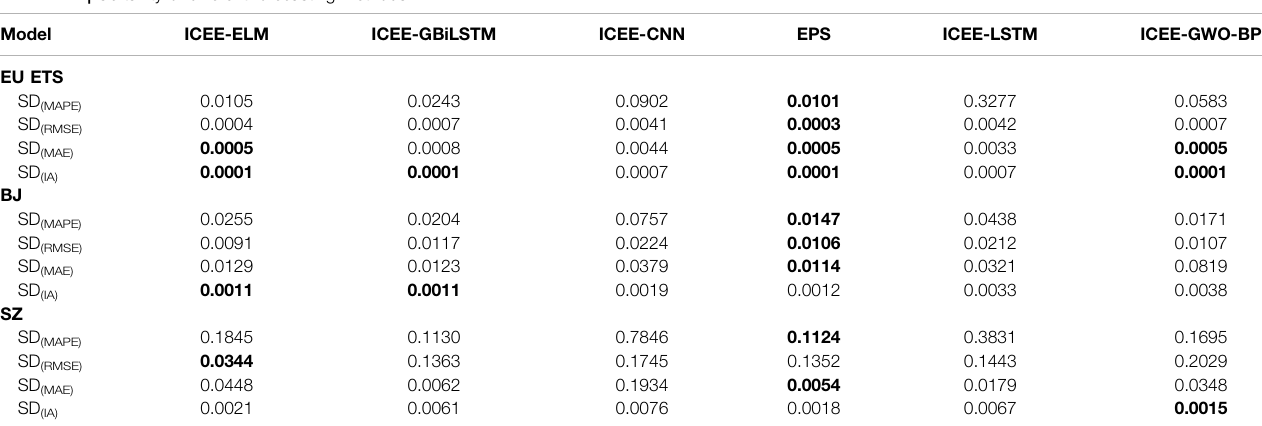
TABLE 11 | Certainty of different forecasting